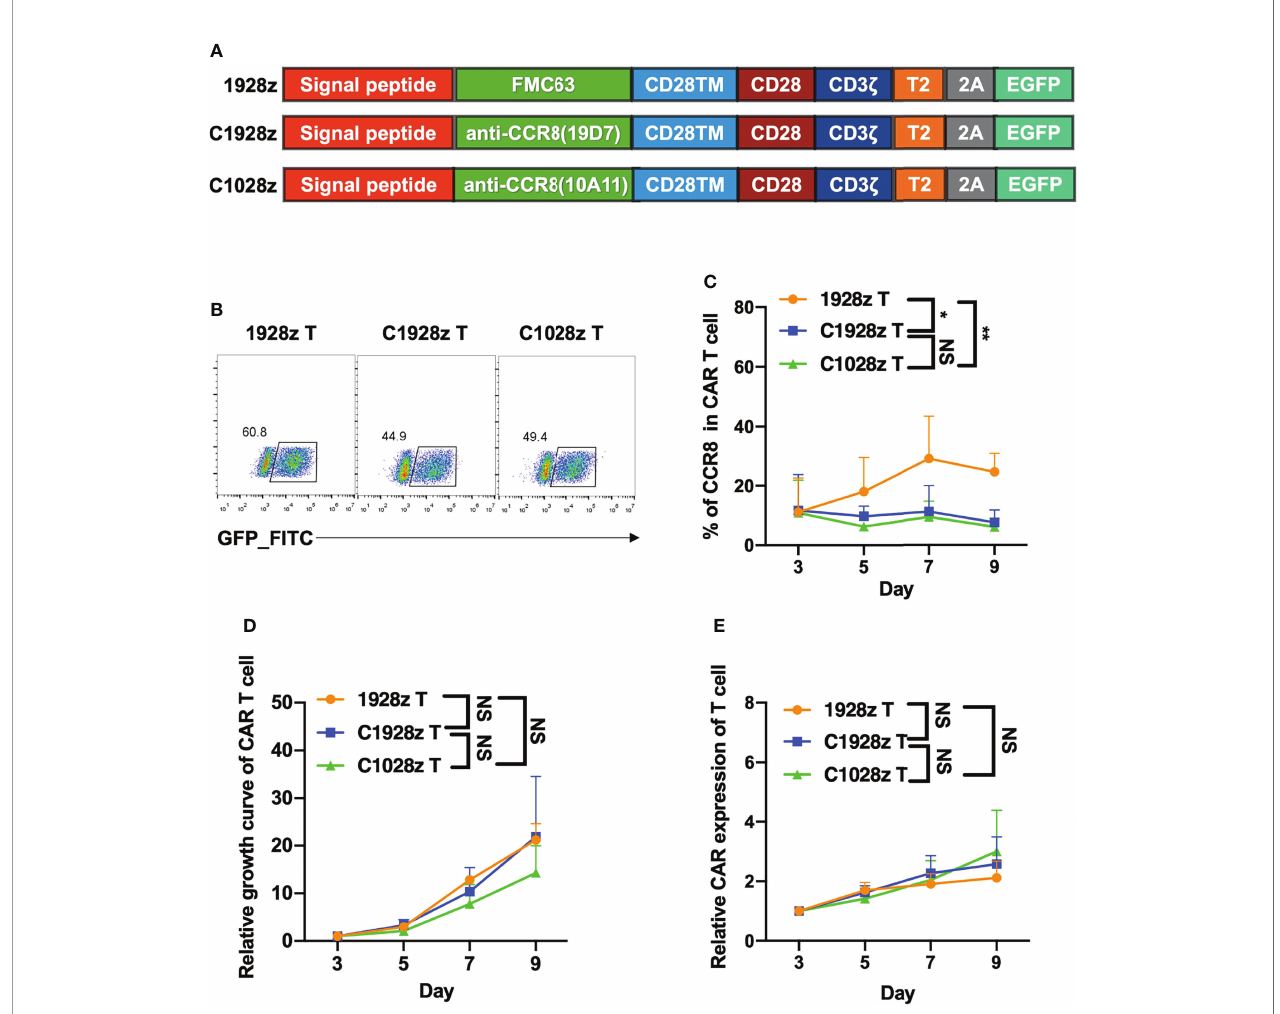
FIGURE 2 | Anti-CCR8 CAR T cells did not impair T cell expansion in vitro . (A) Anti-CD19 CAR vector based on an anti-CD19 scFv (FMC63, 1928z) and two anti- CCR8 CAR vectors based on an anti-CCR8 scFv (10A11, C1028z) and an anti-CCR8 scFv (19D7, C1928z). All vectors contained expression cassettes encoding a human CD8 leader signal peptide, the CD28, CD3 z , TLR2 signaling domains, and EGFP fused to the sequences described in Figure 2A ; (B) CAR expression on CAR T cells was detected by fl ow cytometry; (C) CCR8 expression on CAR T cells was detected by fl ow cytometry at the indicated time for three different donors; (D) The relative growth of CAR T cells was analyzed by fl ow cytometry at the indicated time for three different donors; (E) The CAR level of CAR T cells were detected by fl ow cytometry at the indicated time for three different donors. (C – E) Data are shown as the mean ± SEM values; two-way ANOVA with Tukey ’ s multiple comparisons test; *P < 0.05, **P ≤ 0.01. n.s